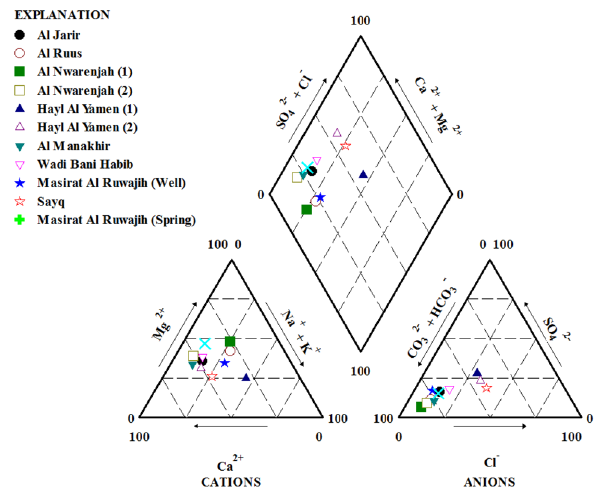
Fig. 6 Piper’s trilinear diagram of groundwater resources of the study area sampled during winter